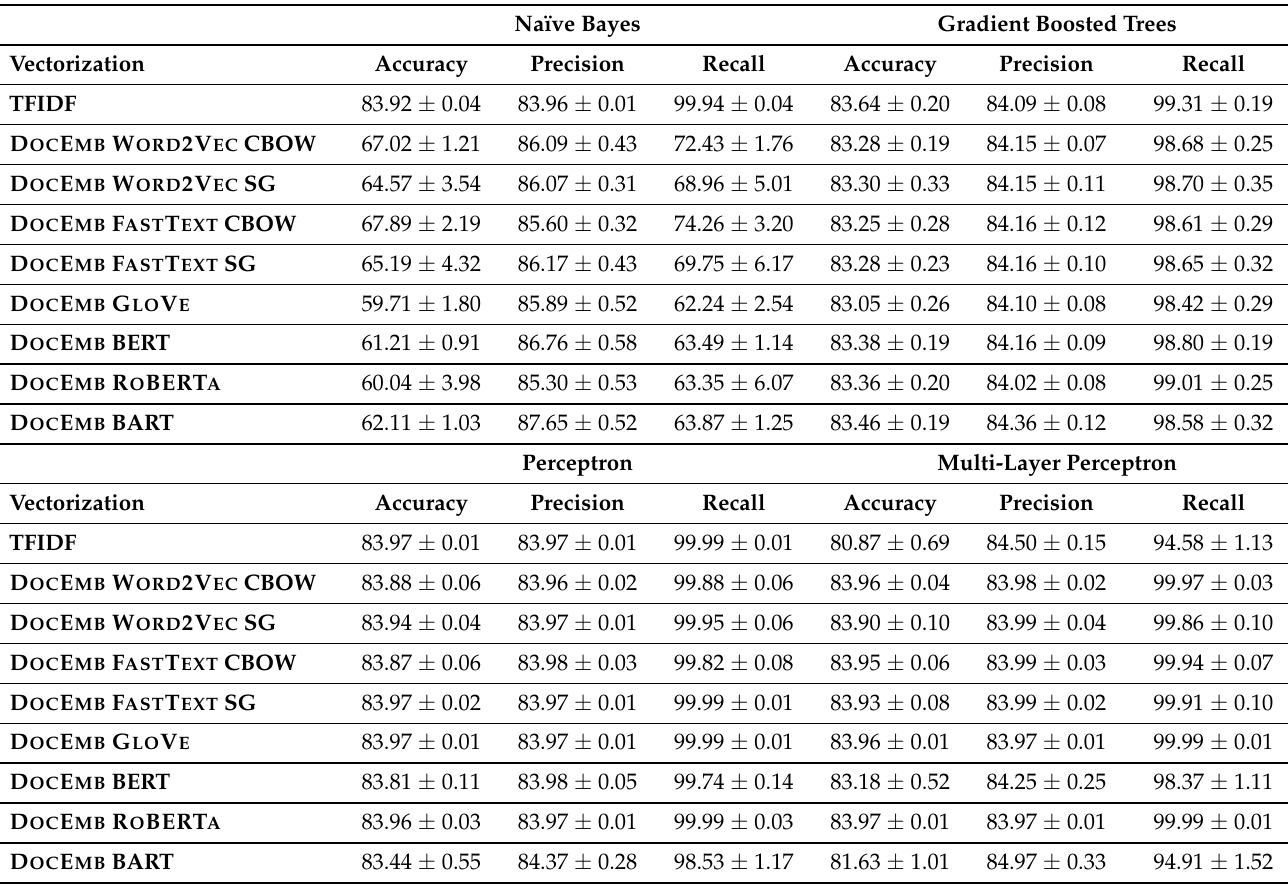
Table 4. Fake news detection results on Liar dataset with 2 labels as presented in Upadhayay and Behzadan